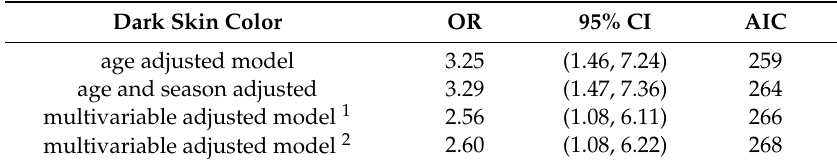
Table 2. Associations between skin color and vitamin D deficiency in 204 pregnant women (reference: vitamin D level ≥ 20